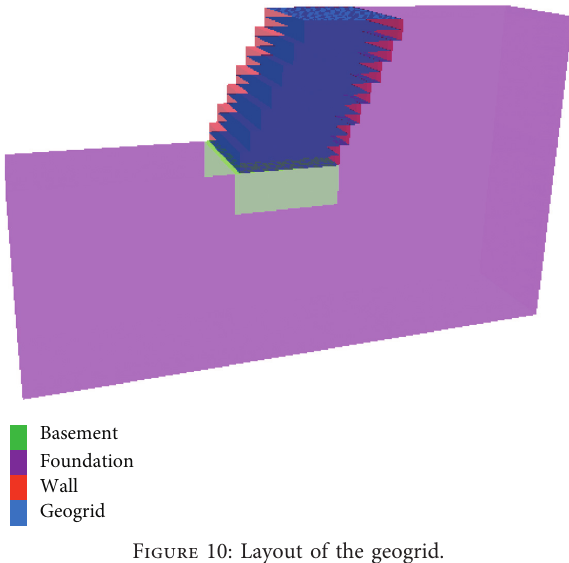
Figure 10: Layout of the geogrid.